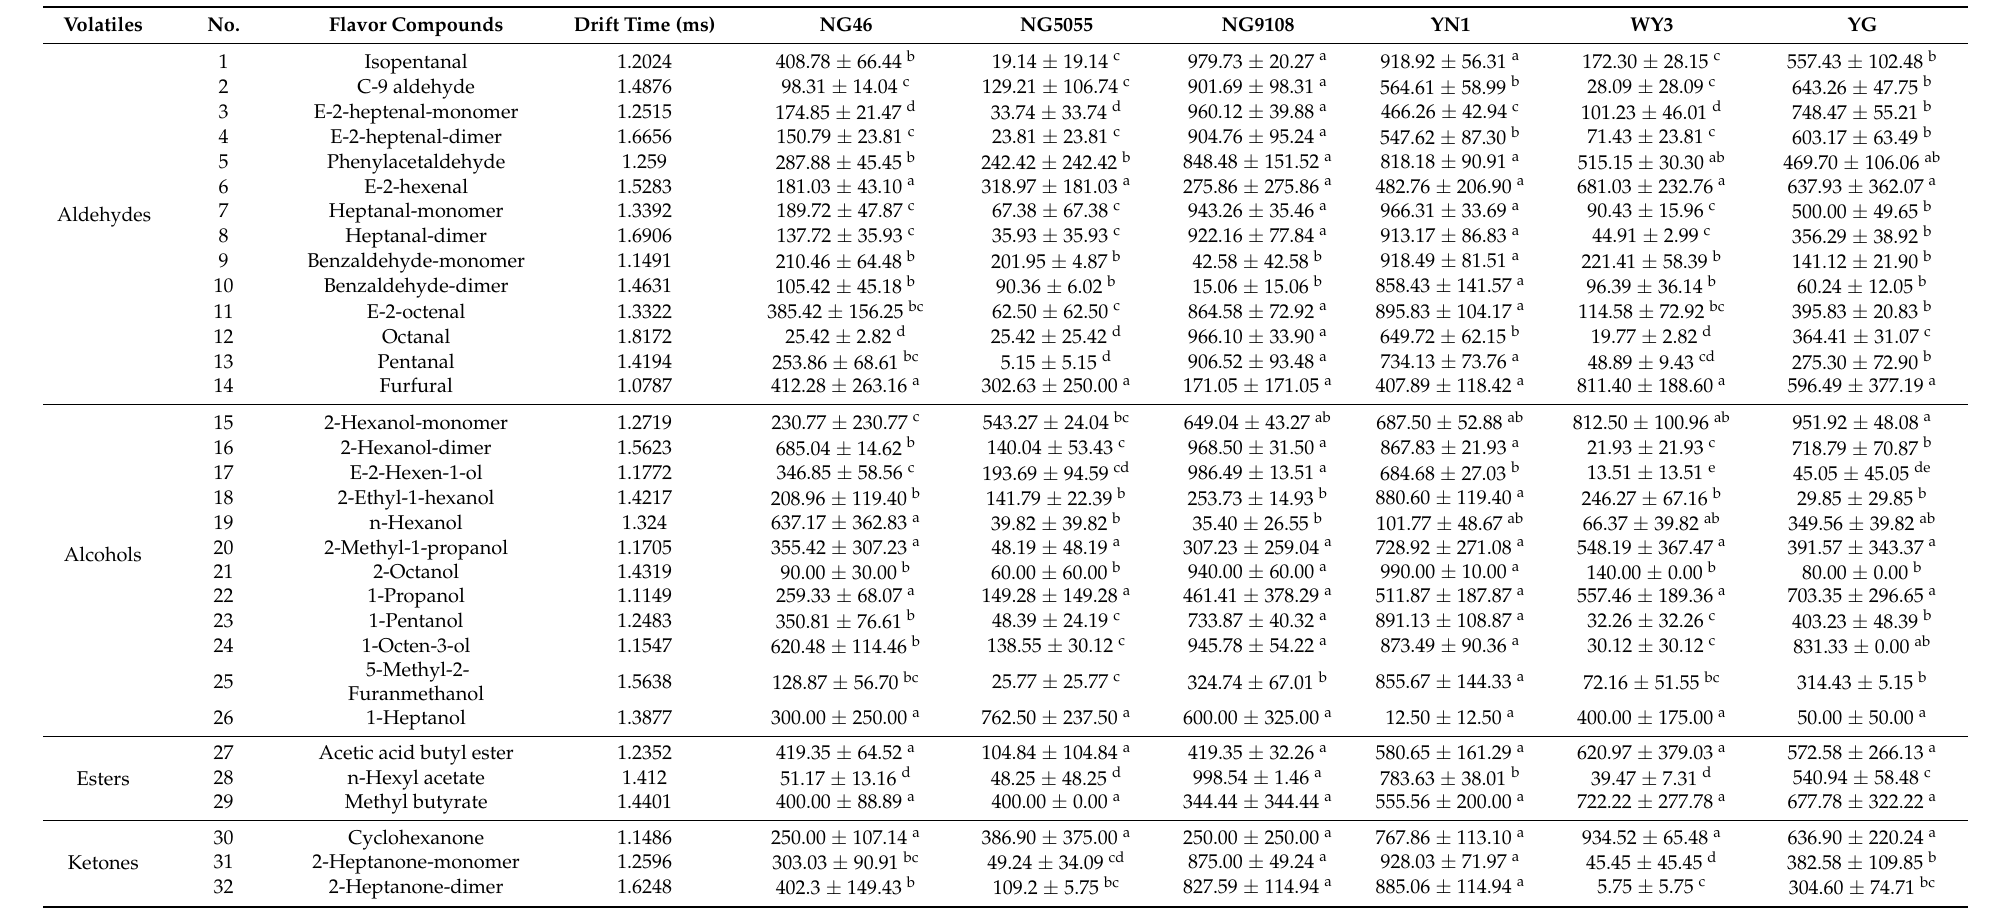
Table 4. Major volatile organic compounds in different cooked rice